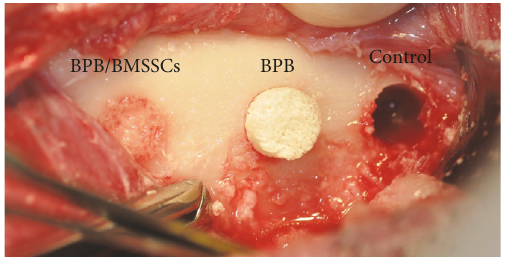
Figure 2: Three critical-size circular defects. Clinical situation during surgery.